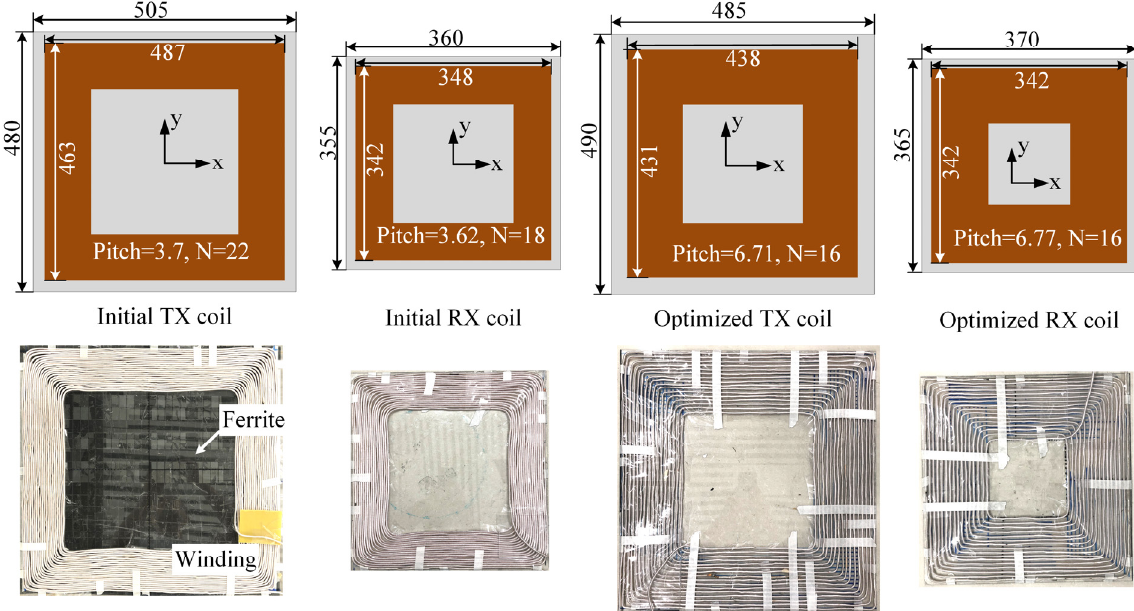
Figure 7. Flowchart of the manual optimization procedure.